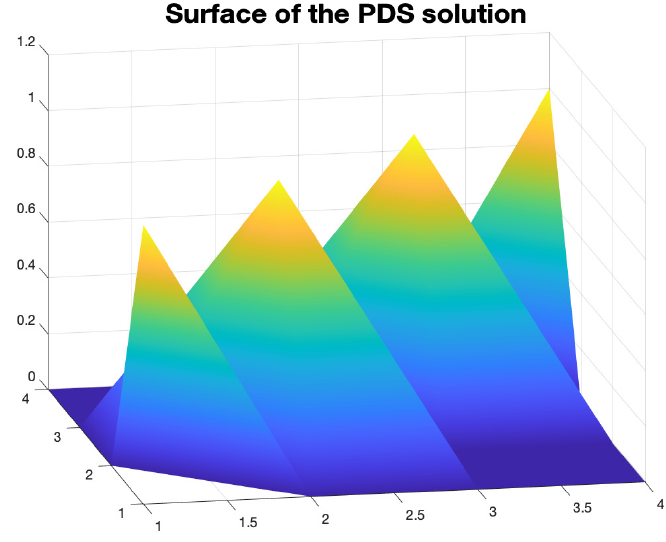
Figure 4. Surface graph of solution for b = 10 10